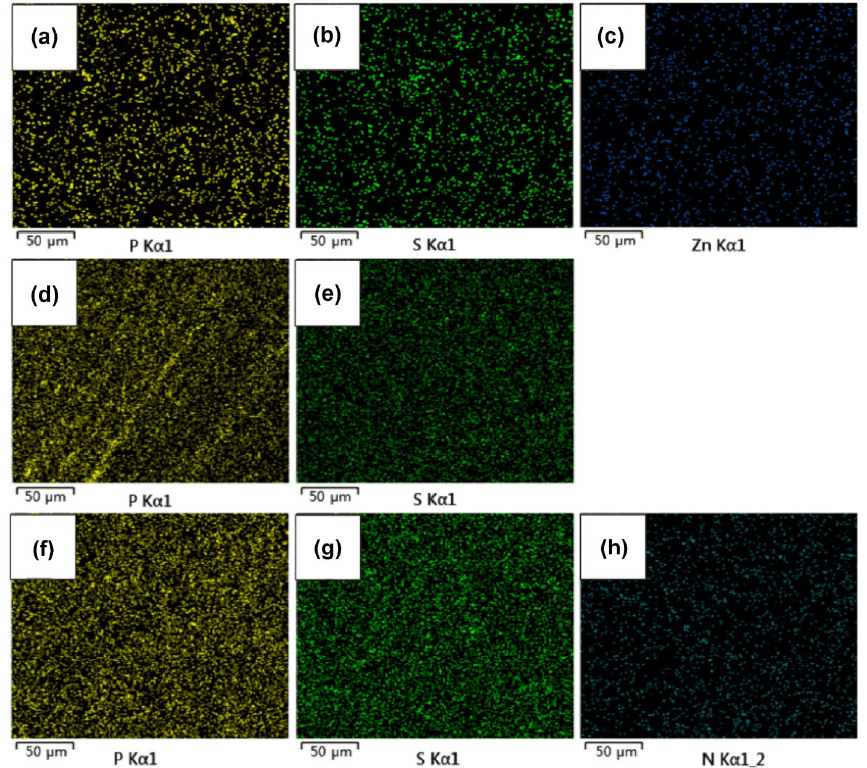
Fig. 12 Section-distribution of wear scars lubricated by (a–c) 1 wt% ZDDP, (d, e) 1 wt% P 888S S P , and (f–h) 1 wt% N 88816 S P at 300 N, 25 Hz, and